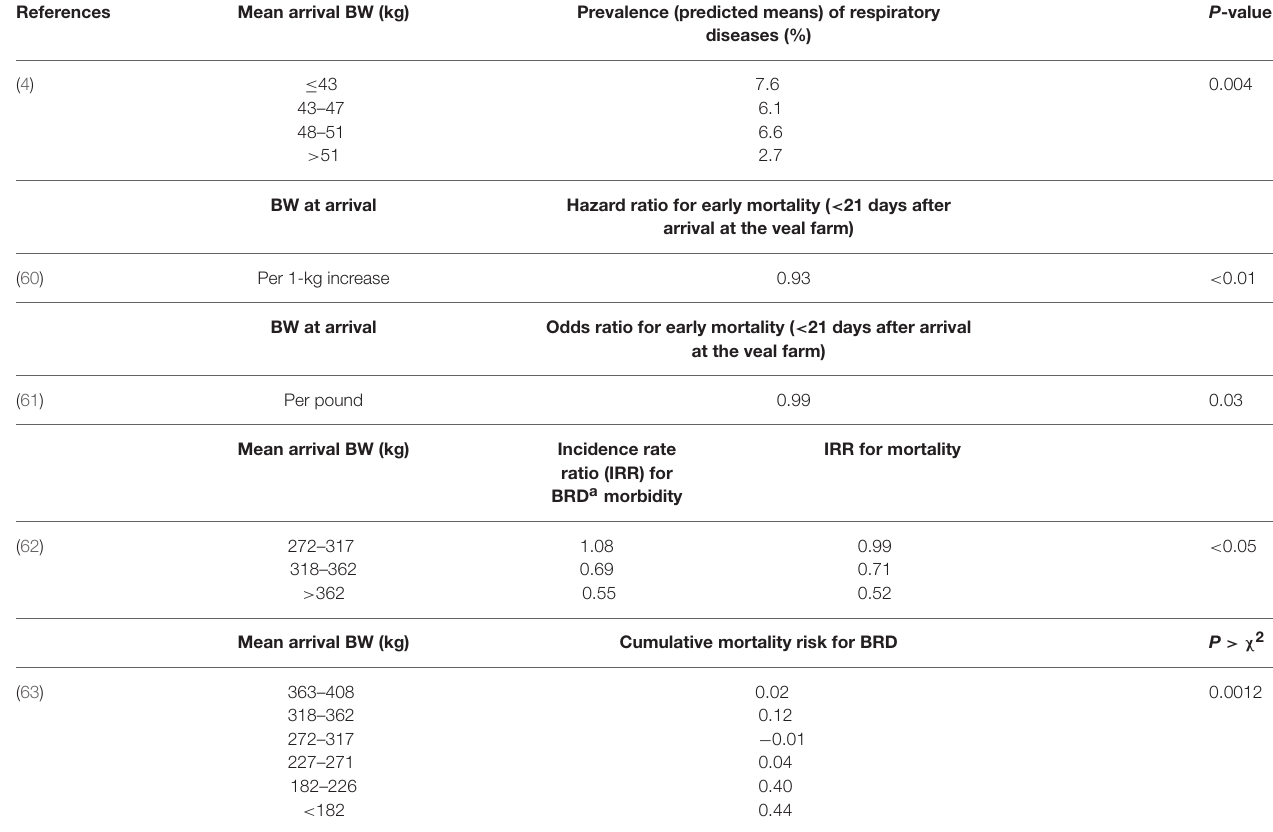
TABLE 1 | Some associations between body weight (BW) and future risk of respiratory diseases or early mortality in different studies on